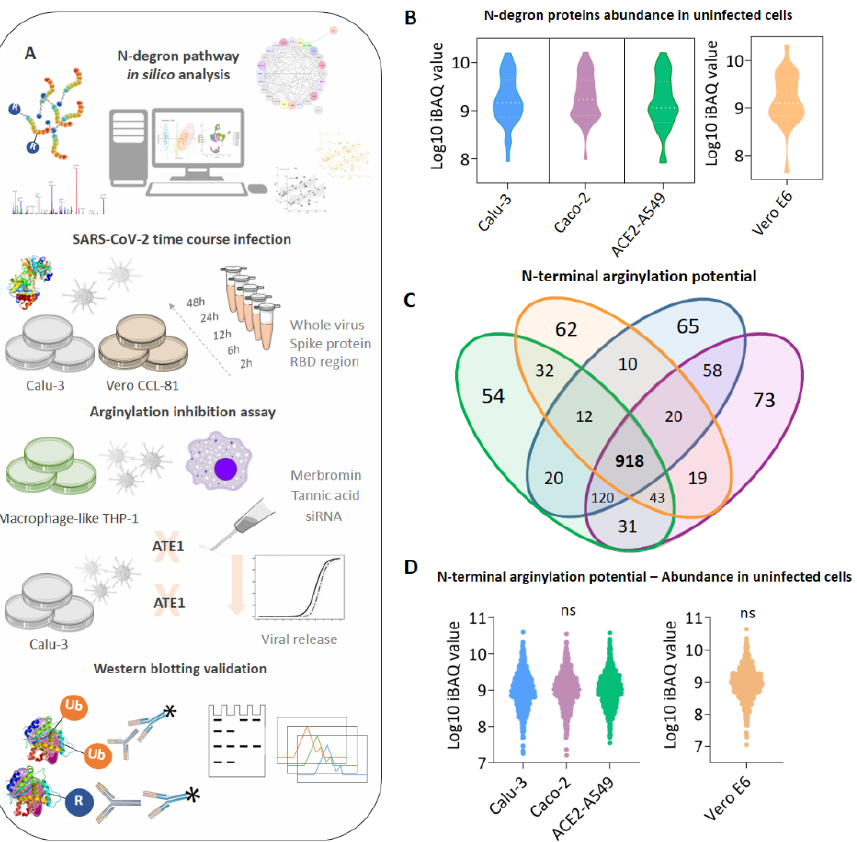
Figure 1. N-degron pathway modulation in uninfected cell models. ( A ) Experimental workflow adopted to identify the modulation of protein arginylation during SARS-CoV-2 infection; ( B ) expression profile of enzymes participating in the N-degron pathway identified in uninfected Calu-3 (blue), Caco-2 (purple), ACE2-A549 (green), and Vero E6 (orange) cells; ( C ) proteins with potential to be arginylated at N-terminal (NtE, NtD, NtC, NtN, NtQ) identified and quantified in uninfected cell models; ( D ) expression profile of the 918 proteins with potential to be arginylated identified in uninfected Calu-3, Caco-2, ACE2-A549, and Vero E6 cells. Proteins with the potential to be arginylated were determined based on their sequences deposited in Uniprot ( Homo sapiens and Chlorocebus sabaeus ). The symbol “ns” indicates a non-significant statistical relationship between